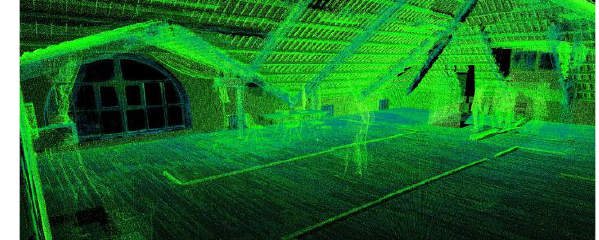
Figure 12 . 3D point cloud for interior design.